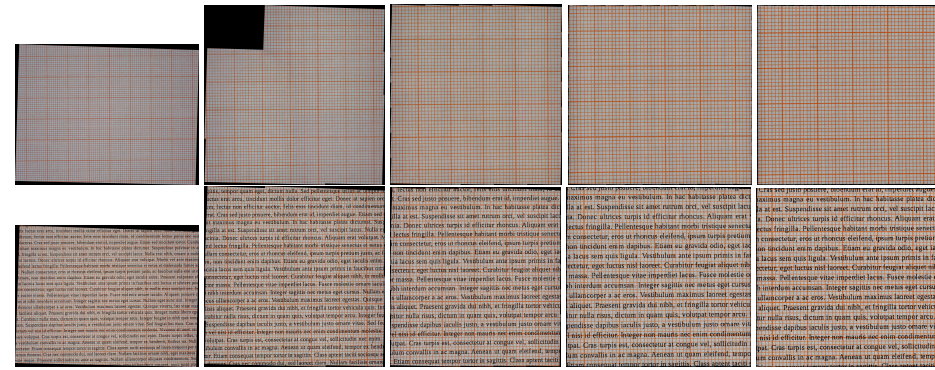
Figure 11. Repetitive patterns.